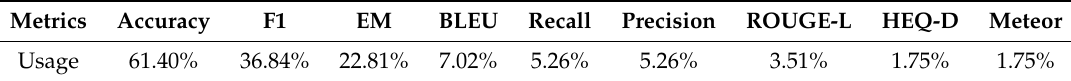
Statistics on the usage of different evaluation metrics in 57 machine reading comprehension